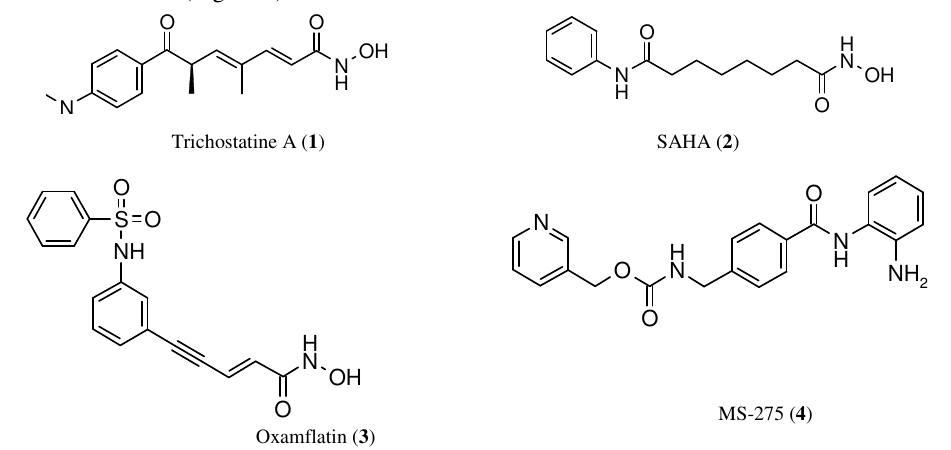
Figure 1 . Structures of known HDAC